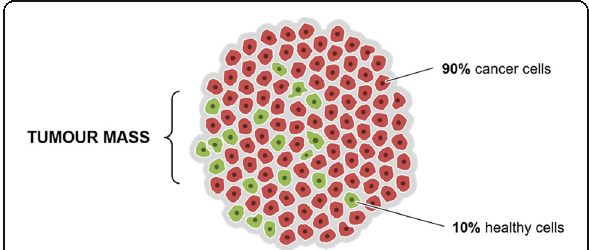
Fig. 5 Composition of an average UM. The majority of cells are mutated cancer cells, while a smaller portion consists of non- mutated healthy cells. Since UM grows in the acellular corpus vitreous, all these cells are part of the tumour. (Percentages are hypothetical but representative as described in De Lange et al.